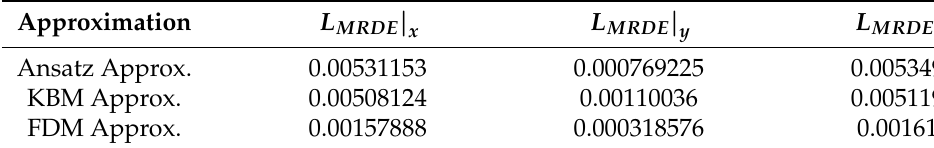
Table 1. The estimation of the MRDE L MRDE for all obtained approximations.